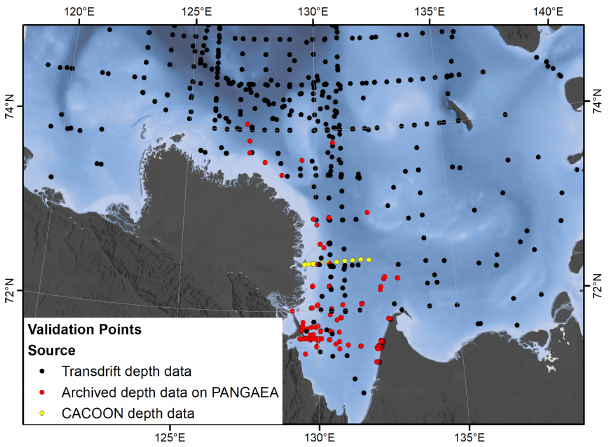
Figure 3. Location of validation points for the Lena Delta region bathymetrical model.